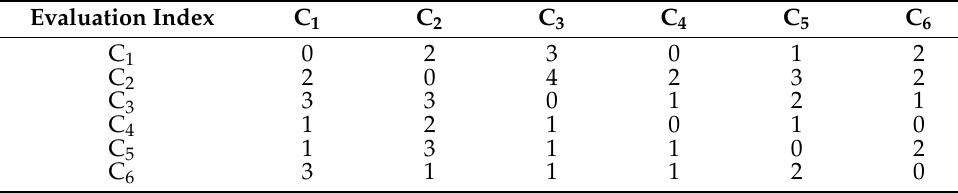
Table 6. Direct correlation matrix Y 1 between indicators of decision maker D 1